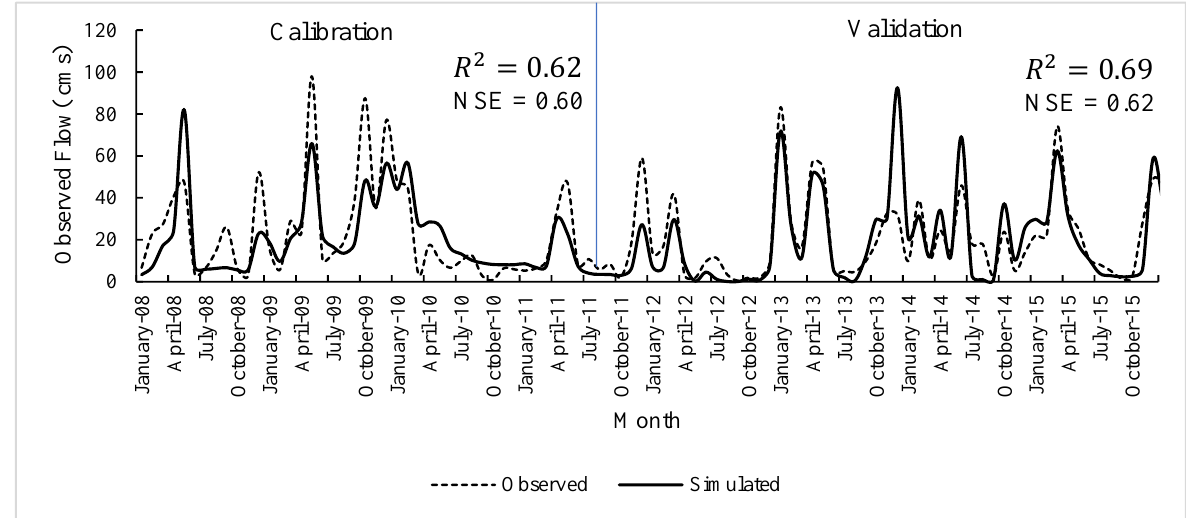
Figure 2. Streamflow calibration and validation for the Merigold Watershed.